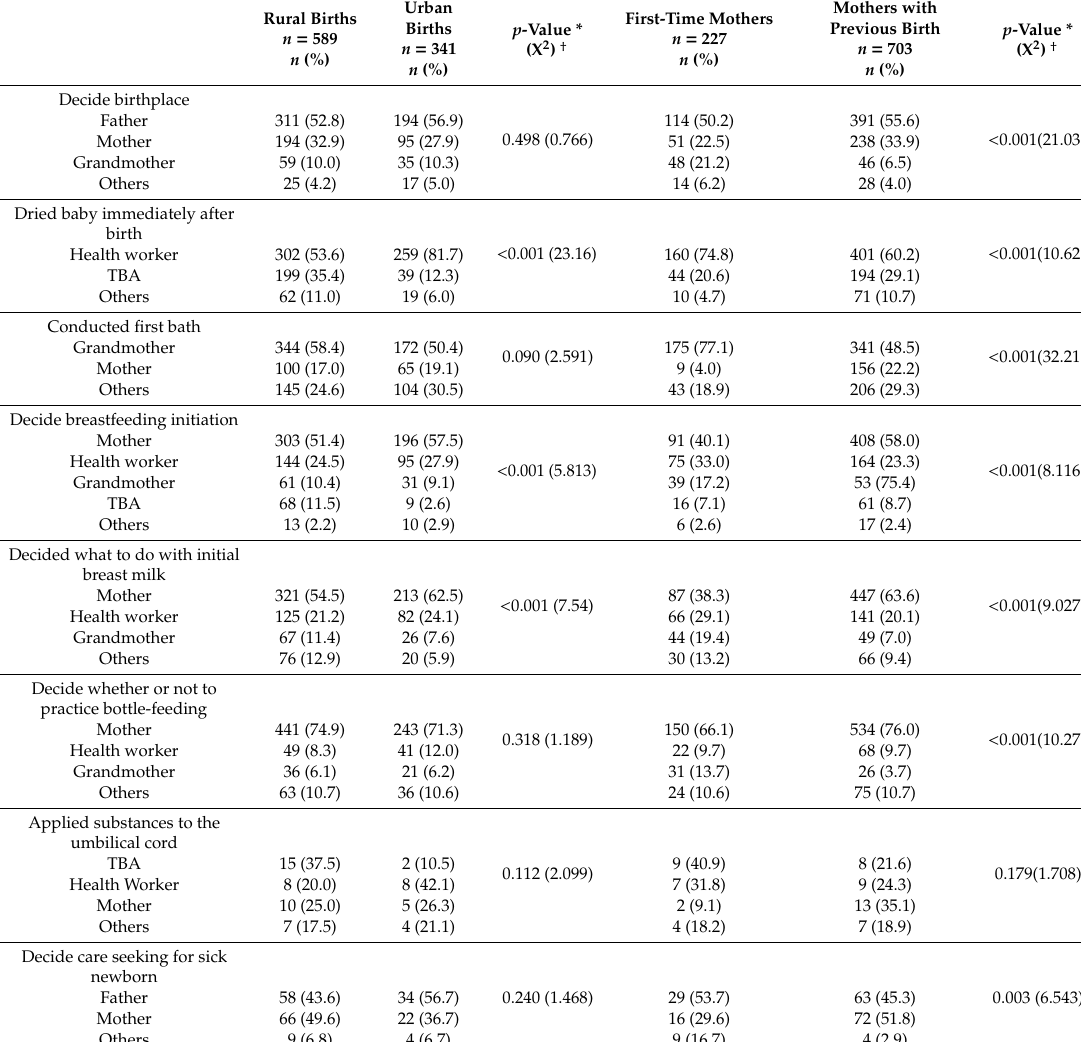
Table 3. Table showing key decision makers and actors in newborn care in Lira district, Northern